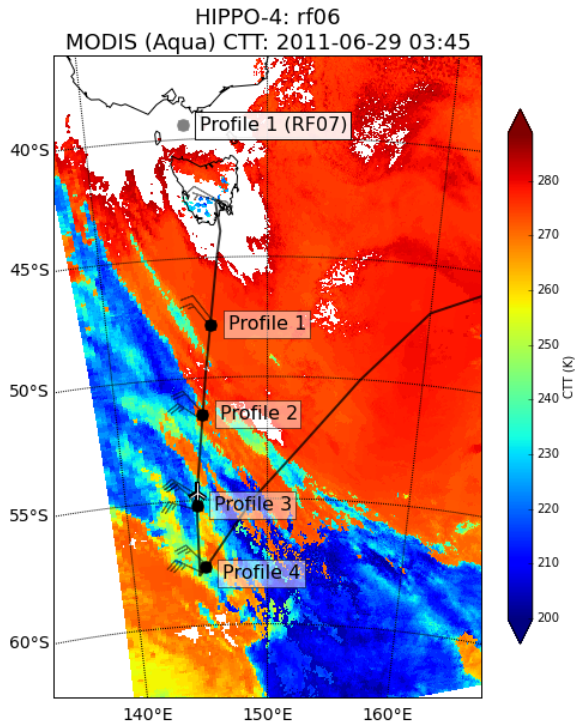
Figure 2. Flight track for HIPPO-4 RF06, with MODIS cloud top temperature overlay. The locations of the lowest level of the four profiles are labeled as per the